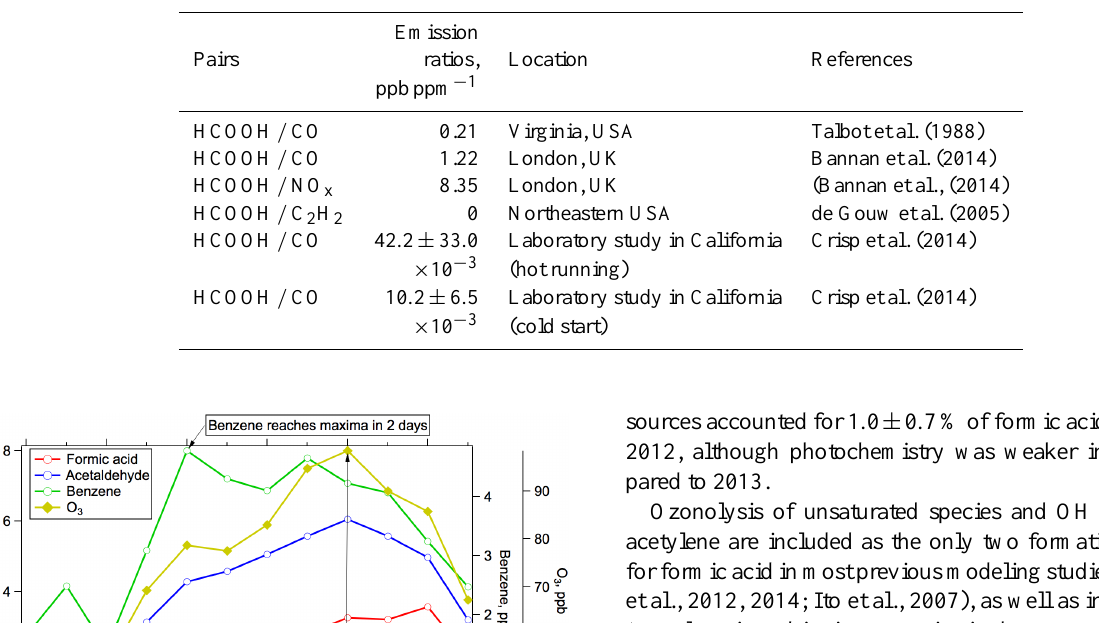
Table 1. Emission ratios (ERs) of formic acid to anthropogenic tracers from combustion emissions reported in the literature.